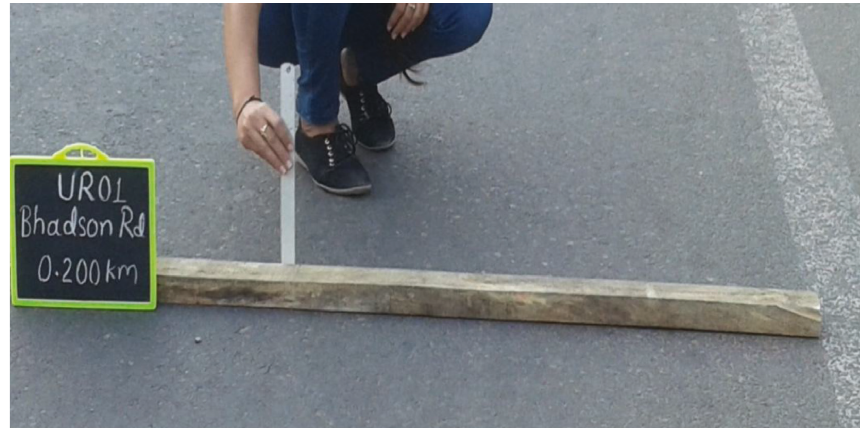
Figure 10: Rut depth measurement at chainage 0.200km on the section UR01.